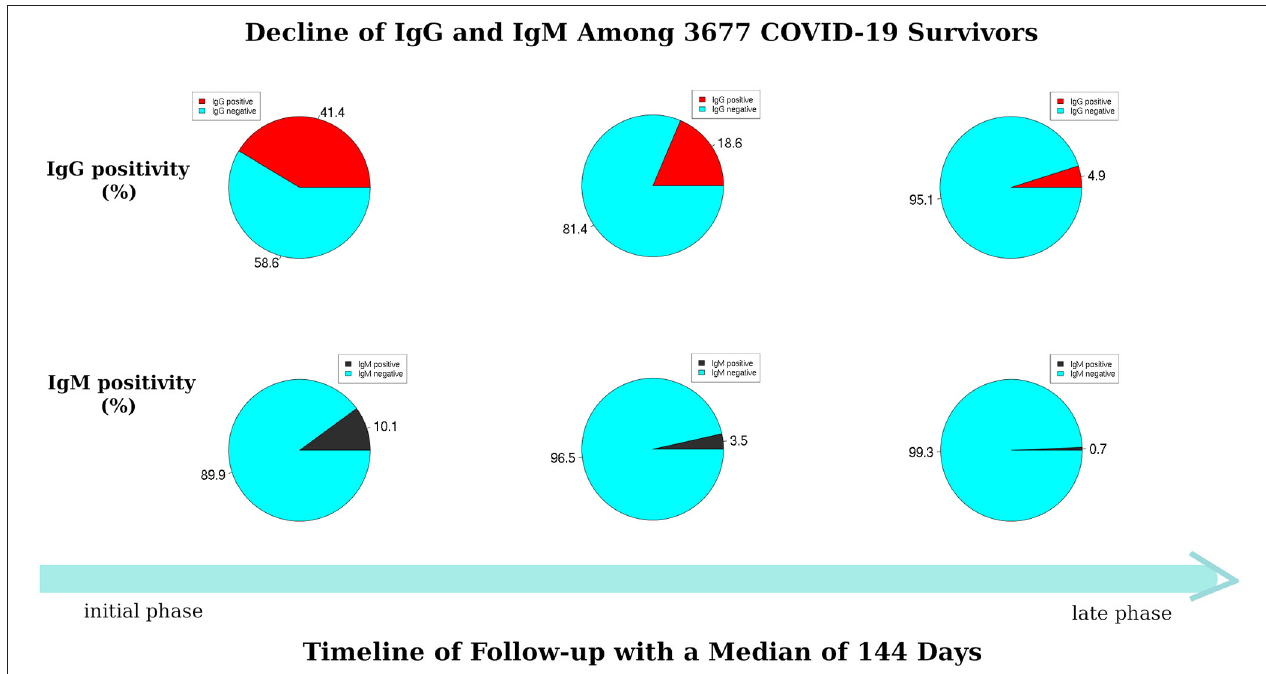
FIGURE 1 | Dynamic decline of immunoglobulin G (IgG) and immunoglobulin M (IgM) among 3,677 coronavirus infectious disease-2019 (COVID-19) survivors during